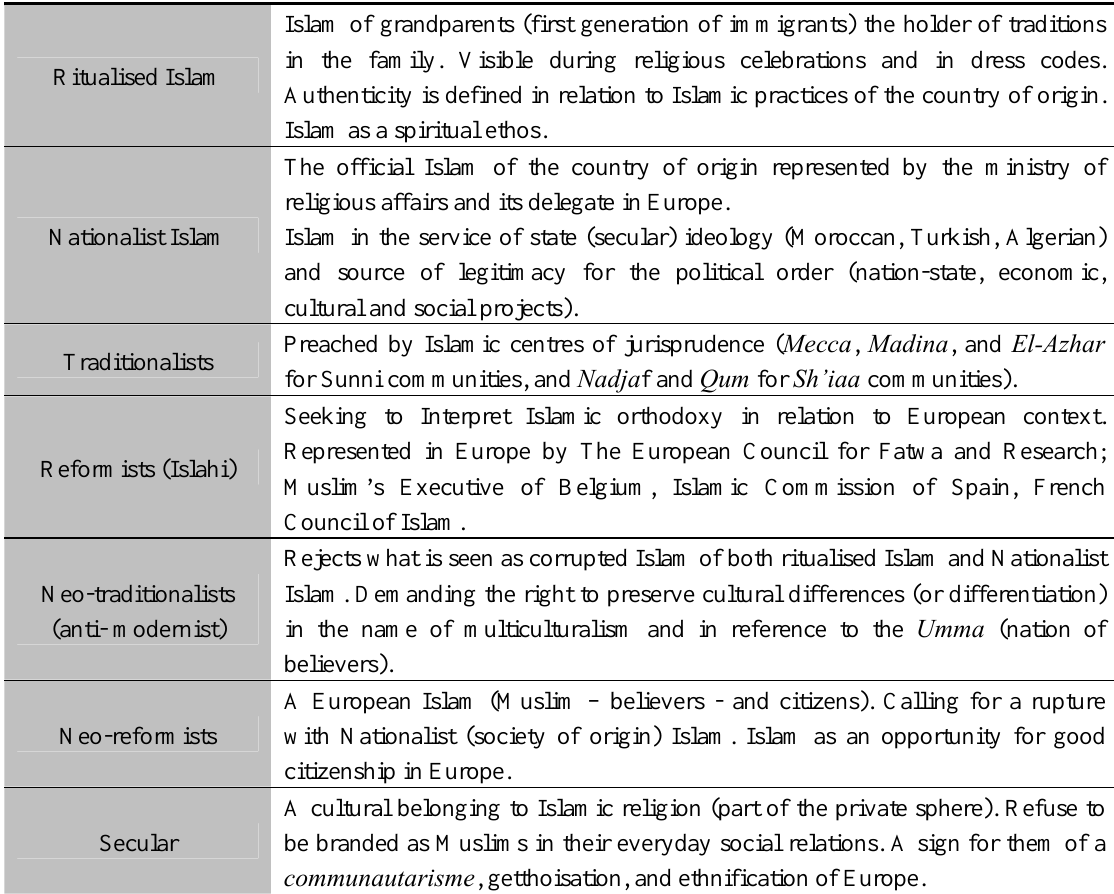
Table 1. Muslim identity and Islamic ‘authenticity’ in the West ([15], p.